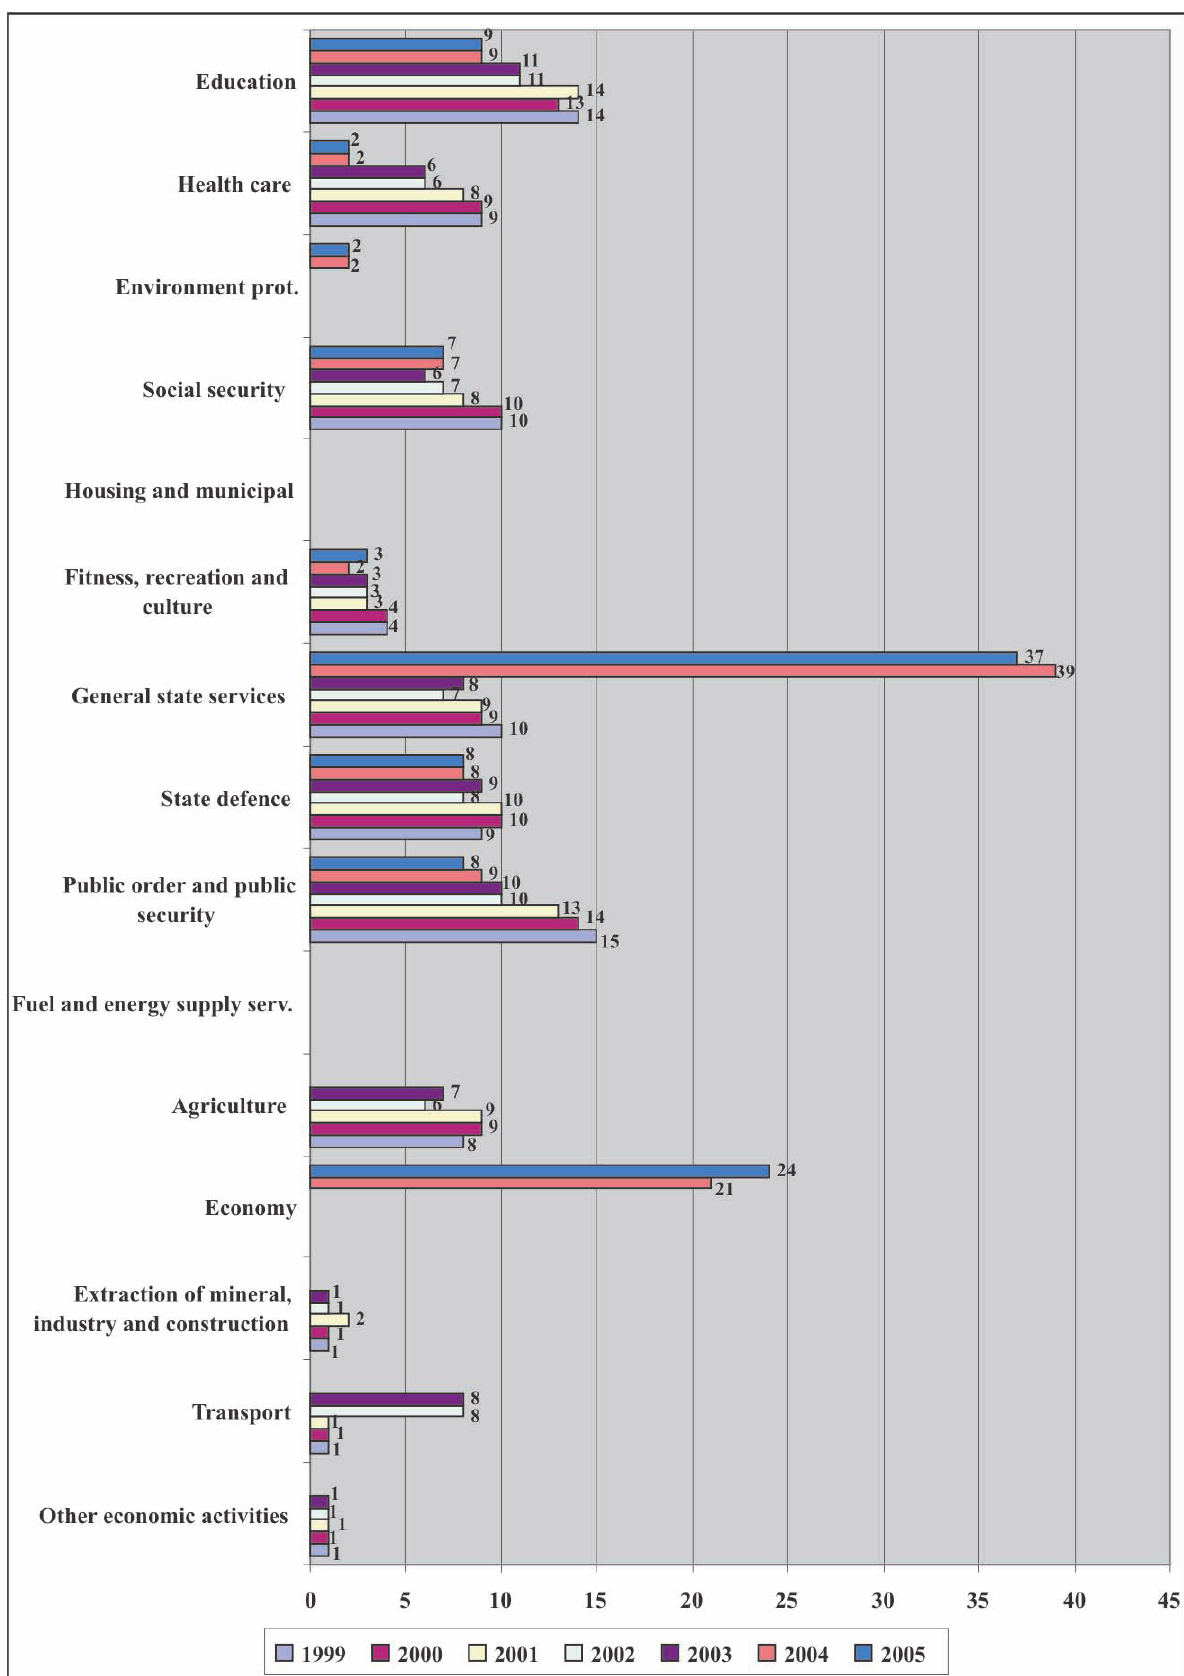
Fig 1. Lithuania’s state budget expenditure by branches of the economy,